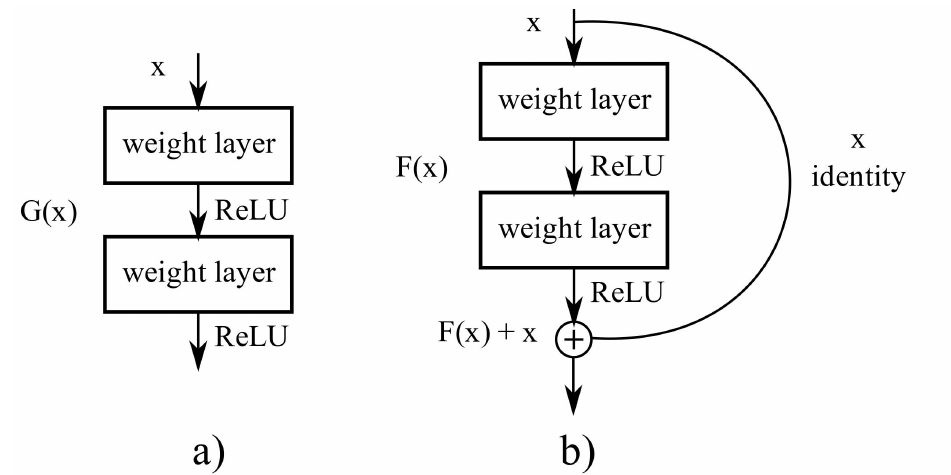
Figure 4. ResNets address the accuracy saturation and accuracy degradation issue with residual blocks. ( a ) Traditional DNN stacking where each layer feeds into the next layer. ( b ) In residual blocks the output of a layers is added to a layer deeper in the